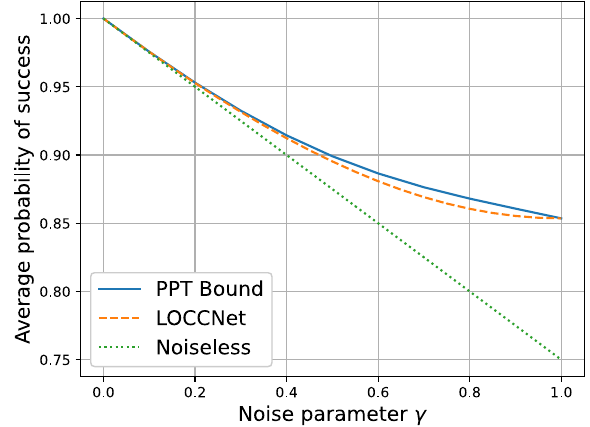
Fig. 7 Average success probability of distinguishing a Bell state and a noisy Bell state. The orange dashed line depicts the behavior of the protocol via LOCCNet, which outperforms the protocol for distinguishing perfect orthogonal Bell states (green dotted). More- over, the protocol from LOCCNet is near optimal since it almost matches the upper bounds obtained via PPT POVMs (blue